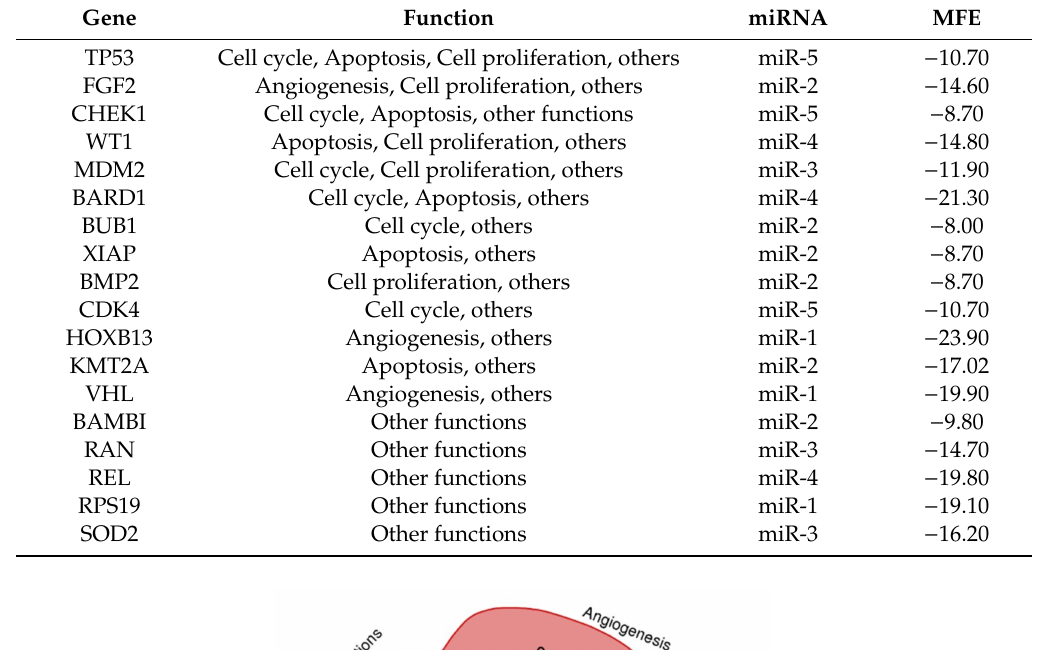
Table 3. Gene enrichment in cancer and their biological functions.